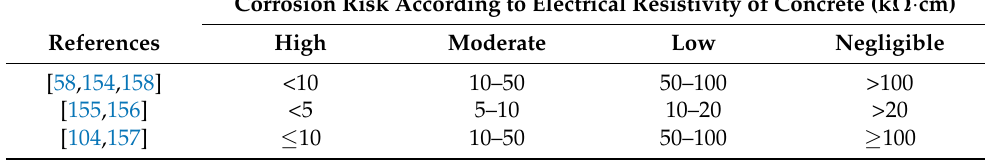
Table 7. Range of electrical resistivities at different corrosion risk